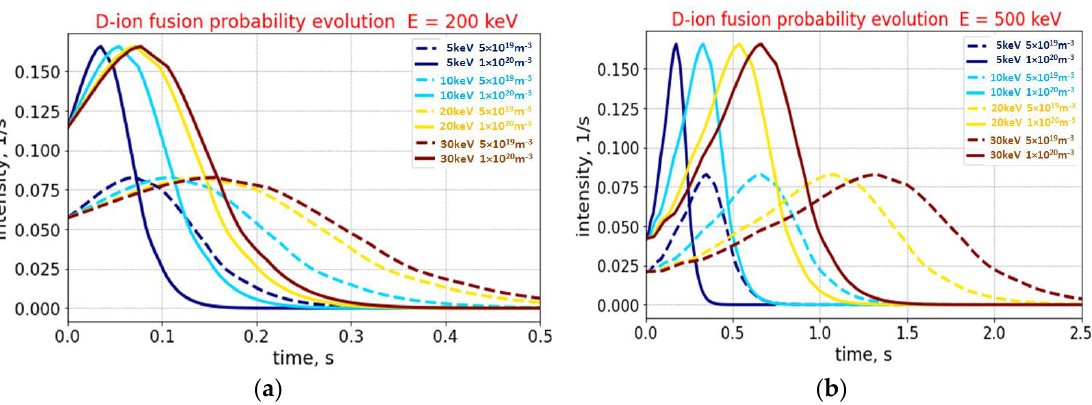
Figure 1. Fast D+ ion fusion and neutron production rate along slowing-down path in plasma calculated for T e = 5, 10, 20, and 30 keV and for n e = 0.5 × 10 20 m −3 (dotted) and n e = 1 × 10 20 m −3 (solid): ( a ) beam energy E b = 200 keV; ( b ) E b = 500 keV. Note the difference in time scales for ( a , b ).